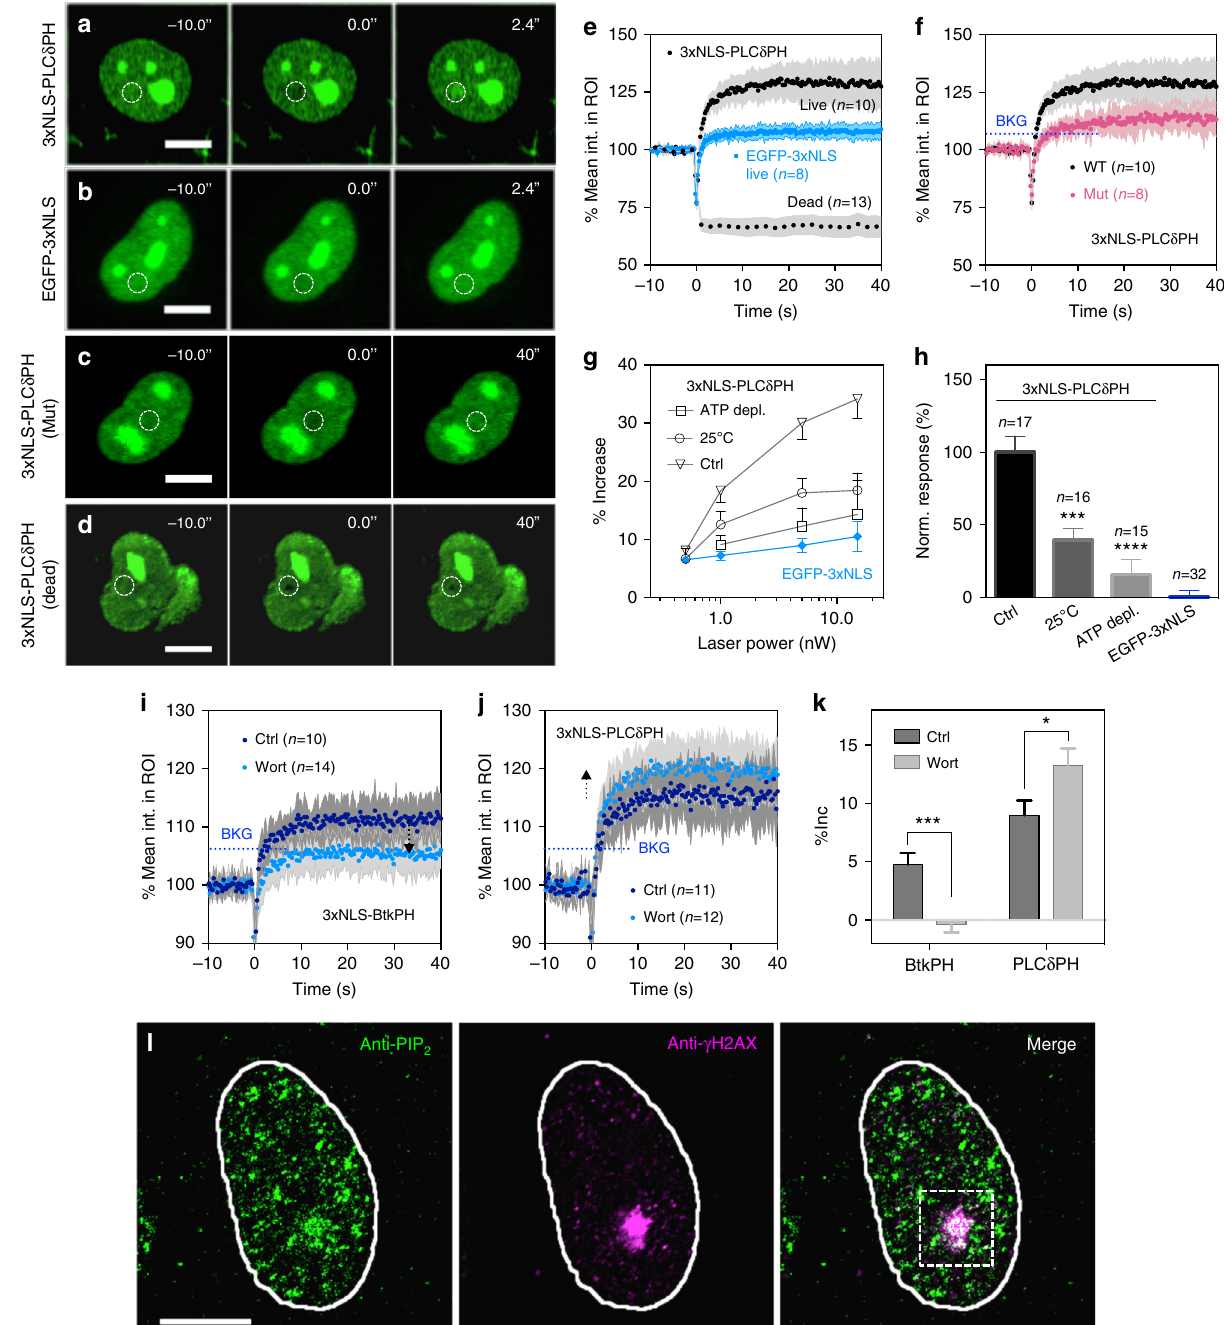
Fig. 3 Active and rapid accumulation of PH domains upon laser microirradiation is wortmannin-sensitive. Confocal montage of cells after laser microirradiation while expressing a 3xNLS-PLC δ PH-EGFP, b 3xNLS-EGFP, c 3xNLS-PLC δ PH Mutant (K30L/K32L/R40L) or d 3xNLS-PLC δ PH-EGFP after cell was killed by addition of 100 mM MEA. e Corresponding quanti fi cation of the mean fl uorescence intensity within ROIs for panels A, B and D. Shaded area represents standard deviation. f Quanti fi cation of the mean fl uorescence intensity within ROIs for panels A and C. Shaded area represents standard deviation. g Laser power-dependent measurement of protein accumulation magnitude within ROIs under control, ATP-depleted condition or at a lower temperature. h Pooled and normalized magnitude of PLC δ -PH accumulation under different conditions after background subtraction as determined by EGFP-3xNLS. i , j The accumulation magnitude of Btk-PH and PLC δ -PH domain, respectively, in the presence or absence of 0.5 μ M wortmannin. Blue dotted line indicates the background level determined by EGFP-3xNLS. Error bars represent mean ± s.d. k The corresponding quanti fi cation of panels i , j with background subtraction. l Representative immuno fl uorescent micrographs of cells stained for PIP 2 and γ H2AX after laser microirradiation. Laser power for damage induction was set as constant at 1 nW for 500 ms except for panel g , h . Scale bars are 10 μ m for all panels. Dashed circles indicate the ROI for laser microirradiation. Data are representative of three independent experiments. All error bars represent mean ± s.e.m. except panel i , j . Student ’ s t -test, * p < 0.05; *** p < 0.001; **** p < 0.0001. n.s. represents not signi fi cant. BKG represents background